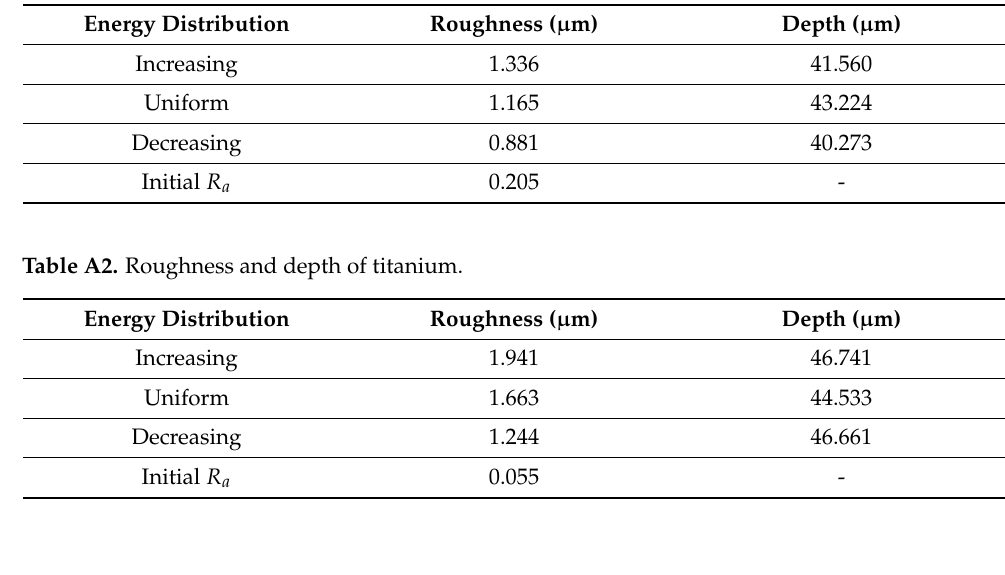
Table A1. Roughness and depth of steel.